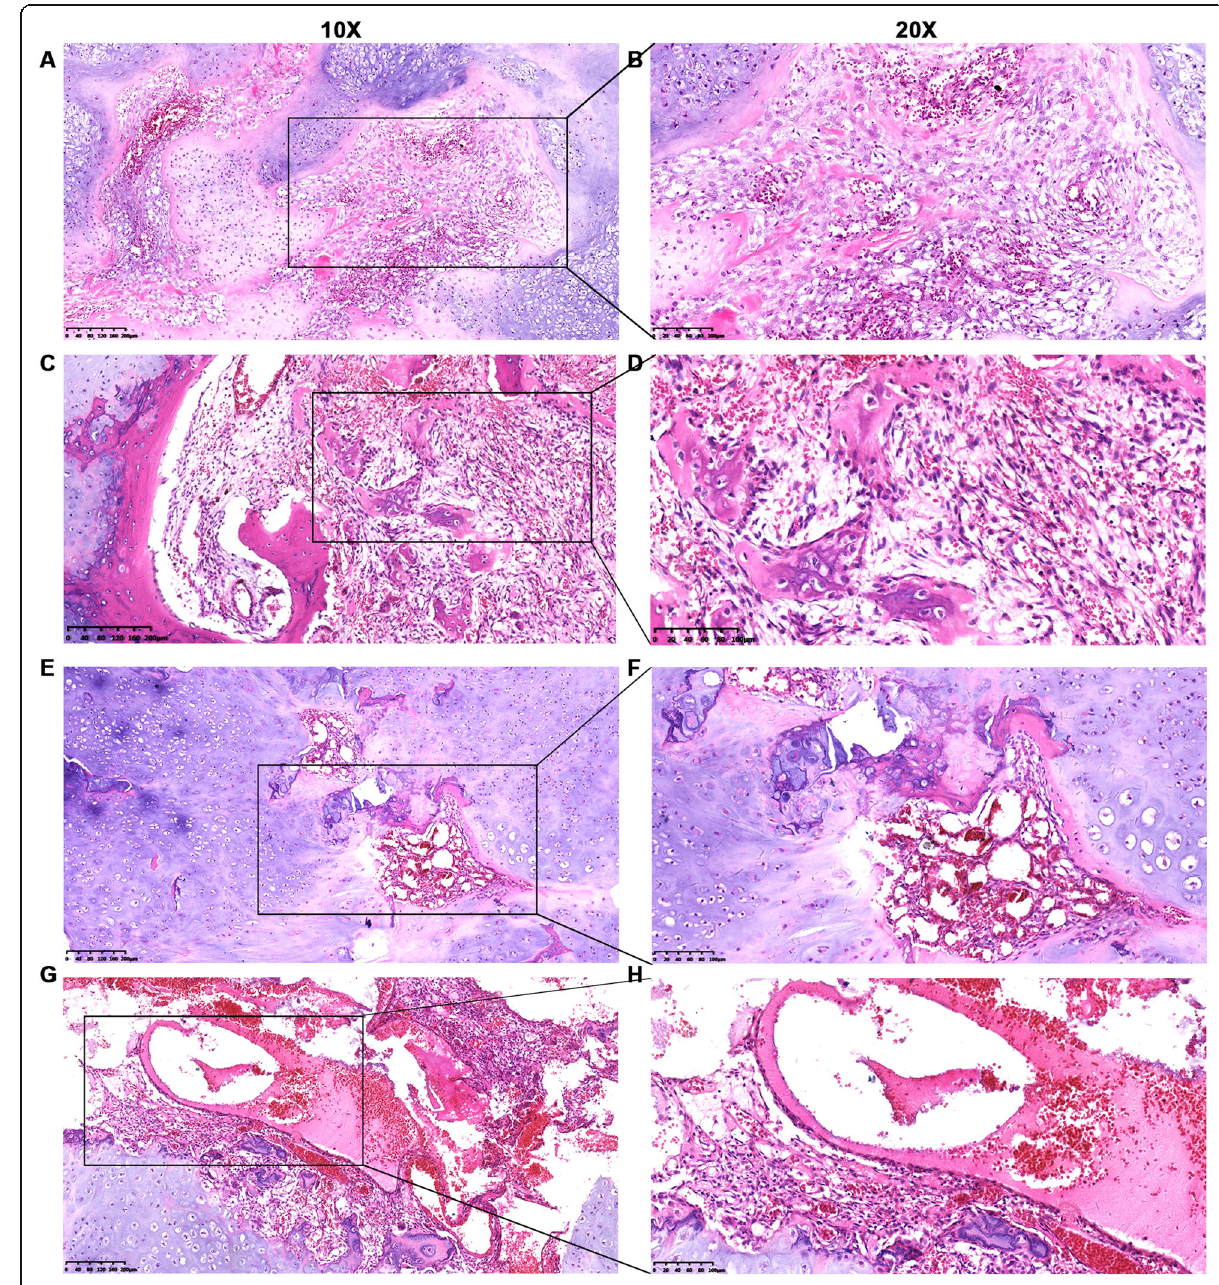
Fig. 5 Pathological features of chondromesenchymal hamartoma (HE staining) in case 2. a , b Fascicles of mesenchymal spindle cells interwoven with multilobulated hypercellular hyaline cartilage. c , d Disorganized mixture of cartilage, spindle cells, osteoid trabeculae, and osteoclastic giant cells. e , f Focal myeloid tissues and osteoid trabeculae scattered among hypercellular plate-like cartilage. g , h Fragmented cartilage mixed with osteoid trabeculae, osteoclast-like giant cells, and blood-filled spaces enclosed by fibrous connective cyst walls. Left panel, × 10; right panel, × 20. HE, hematoxylin and